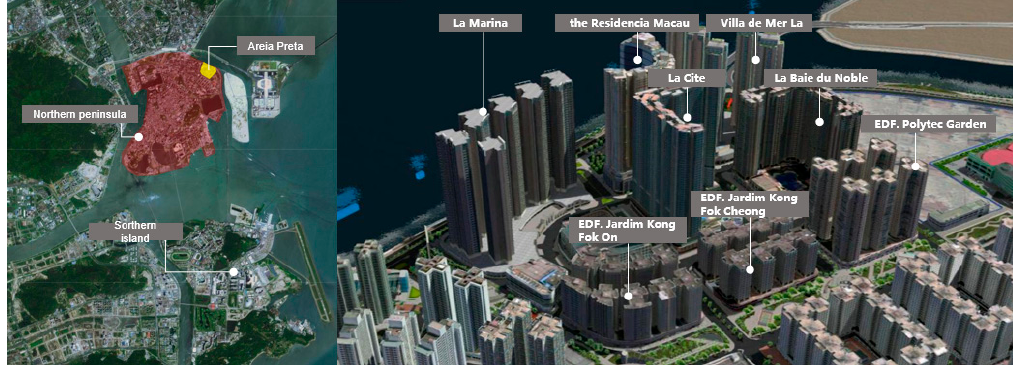
Figure 1. Study Area.